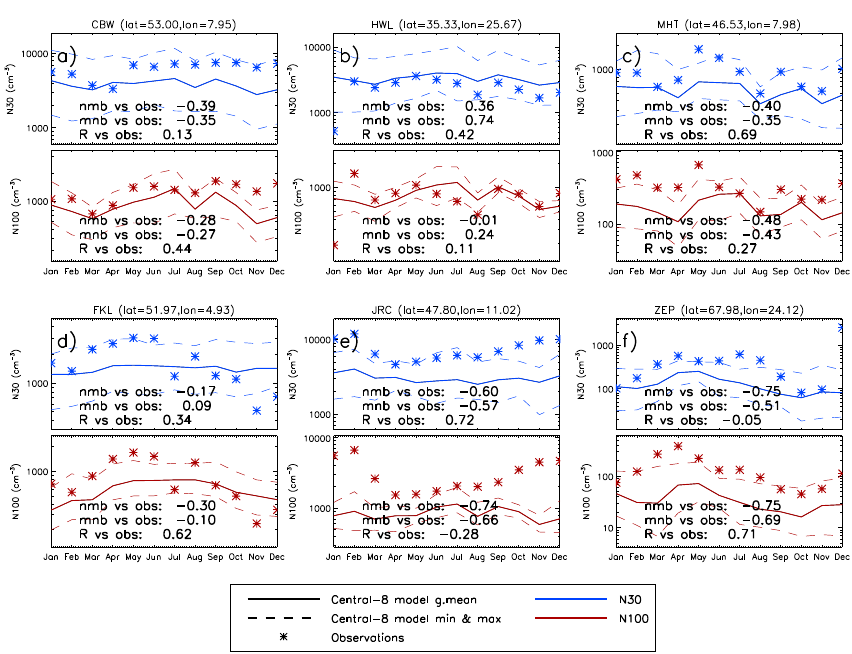
Figure 12. Annual cycle of simulated N(D p > 30nm) (blue) and N(D p > 100nm) (red) against those measured by SMPS/DMPS instru- ments (asterisks) at the six EUSAAR sites classified as western Europe: Cabauw (CBW, a ), Harwell (HWL, b ), Mace Head (MHT, c ), Mediterranean: Finokaklia (FKL, d ), Ispra (JRC, e ), or Arctic: Zeppelin (ZEP, f ). Model values are the geometric mean (solid) and min/max (dashed) over the central-8 model monthly (arithmetic) mean values. Observed values are arithmetic means over the hourly measurement data (A. Asmi, personal communication,